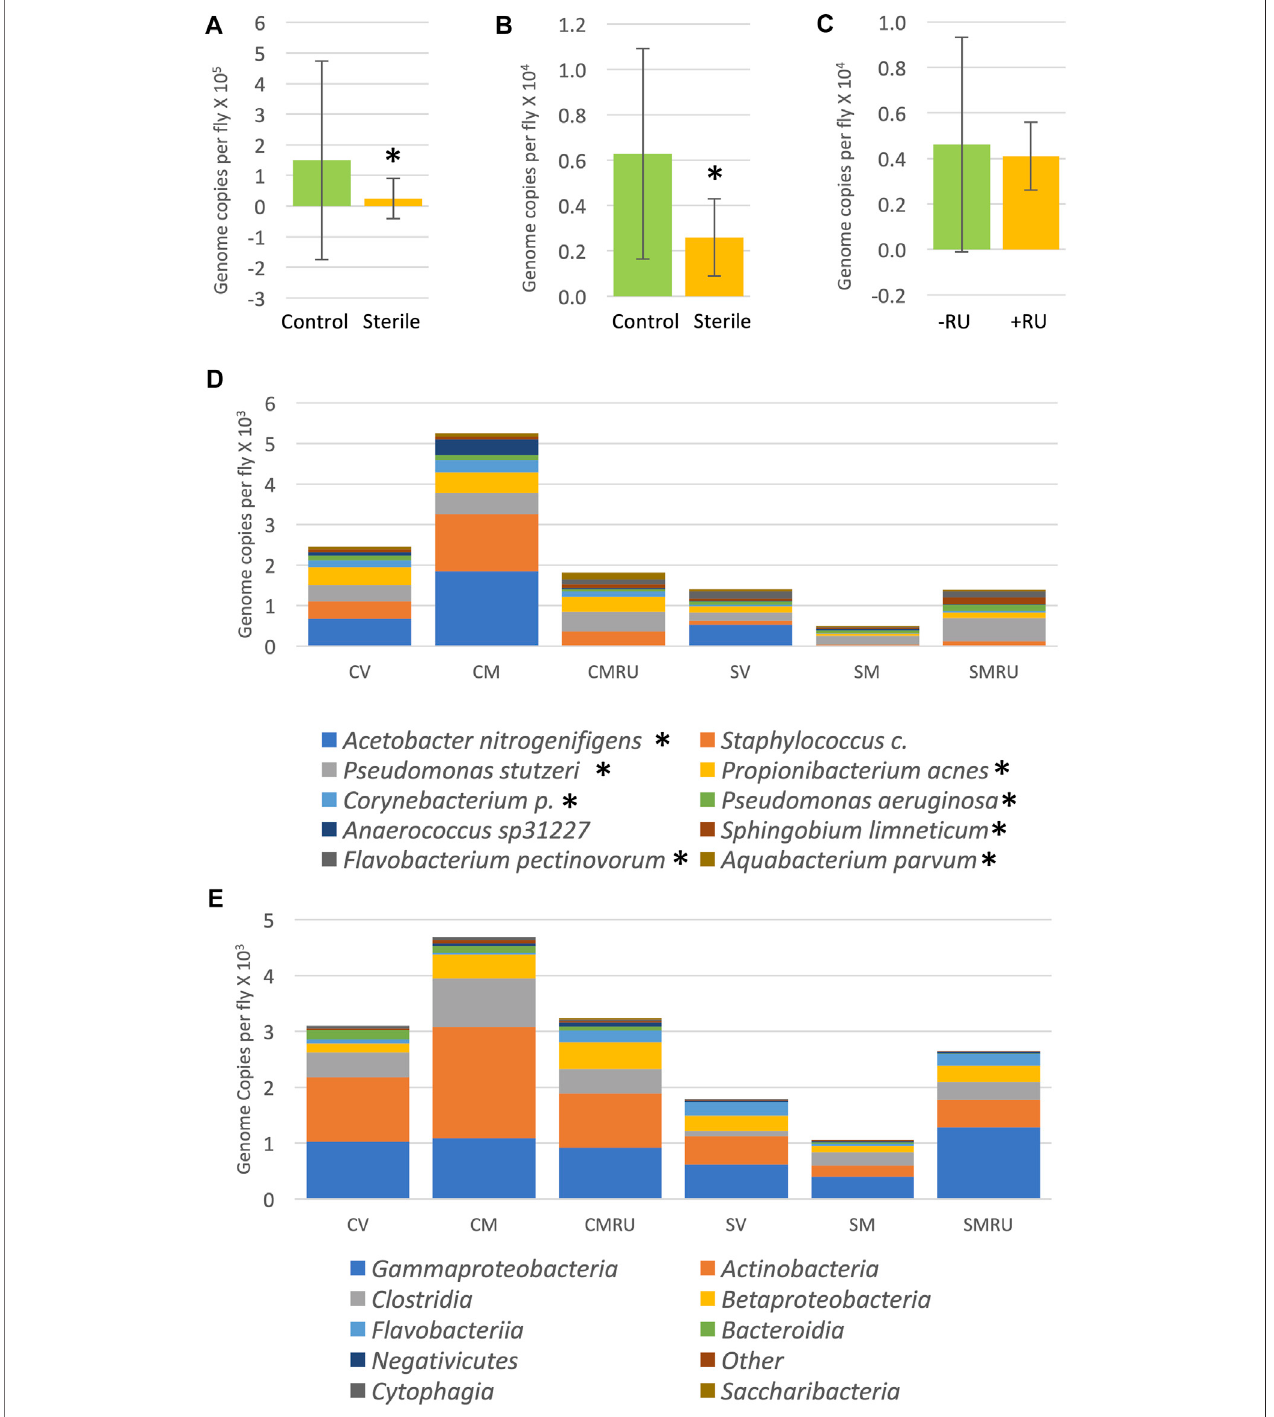
FIGURE 3 | Effect of egg sterilization and mifepristone on adult female bacterial species and classes. (A) Total bacterial load of control fl ies compared to sterile condition fl ies, including outliers. Mann – Whitney p = 0.0145 (indicated with asterisk). (B) Total bacterial load of control fl ies compared to sterile condition fl ies, excluding outliers. Mann – Whitney p = 0.0173 (indicated with asterisk). (C) Total bacterial load of nontreated fl ies ( − RU) compared to mifepristone (RU486) – treated fl ies (+RU), excluding outliers. Mann – Whitney p = 0.3286. (D) Average top ten species (excluding outliers). (E) Average top ten classes (excluding outliers). CV, control virgins; CM, control mated; CMRU, control mated plus mifepristone/RU486; SV, sterile virgins; SM, sterile mated; and SMRU, sterile mated plus mifepristone/RU486. Species and classes reported to be aero-tolerant are indicated with asterisk.